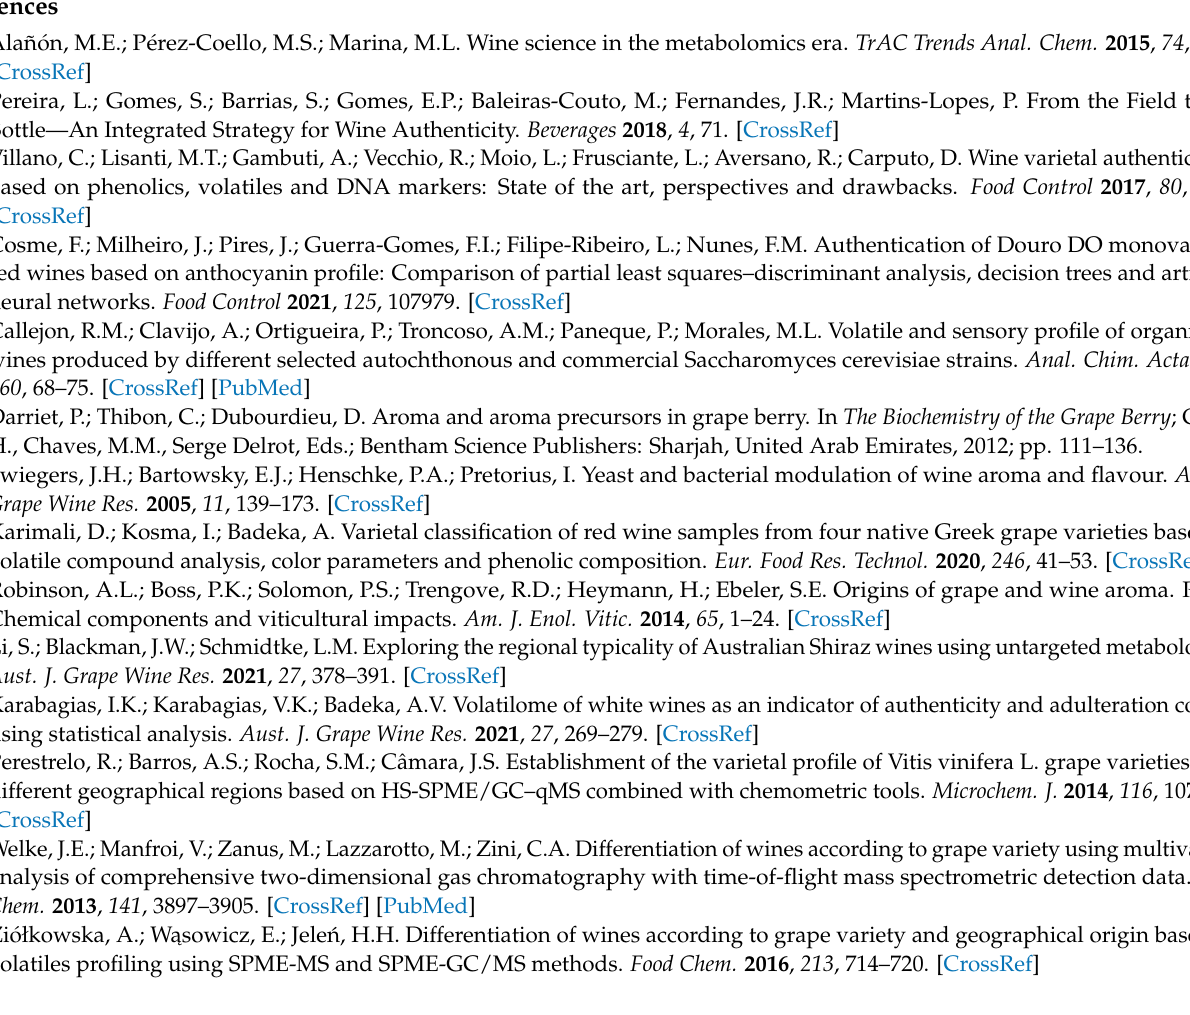
Table 1 for compound names); Figure S2: GC/MS chromatogram of volatile compounds of Rondo wine (see Table 1 for compound names); Table S3: p -values obtained by the Mann-Whitney test when comparing Zweigelt and Rondo wines; Figure S3: Projection of variables on the PCA plane defined by the first two principal components (numbers 1–67 stand for volatile compounds; see Table 1 for their